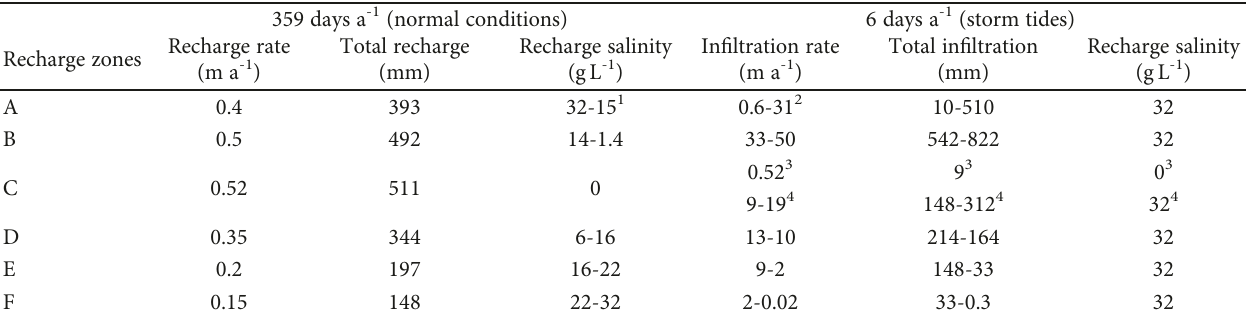
Table 2: Overview of the implemented recharge and in fi ltration rates, respectively, and recharge salinities under normal conditions (359 days a year) and during storm tides (6 days a